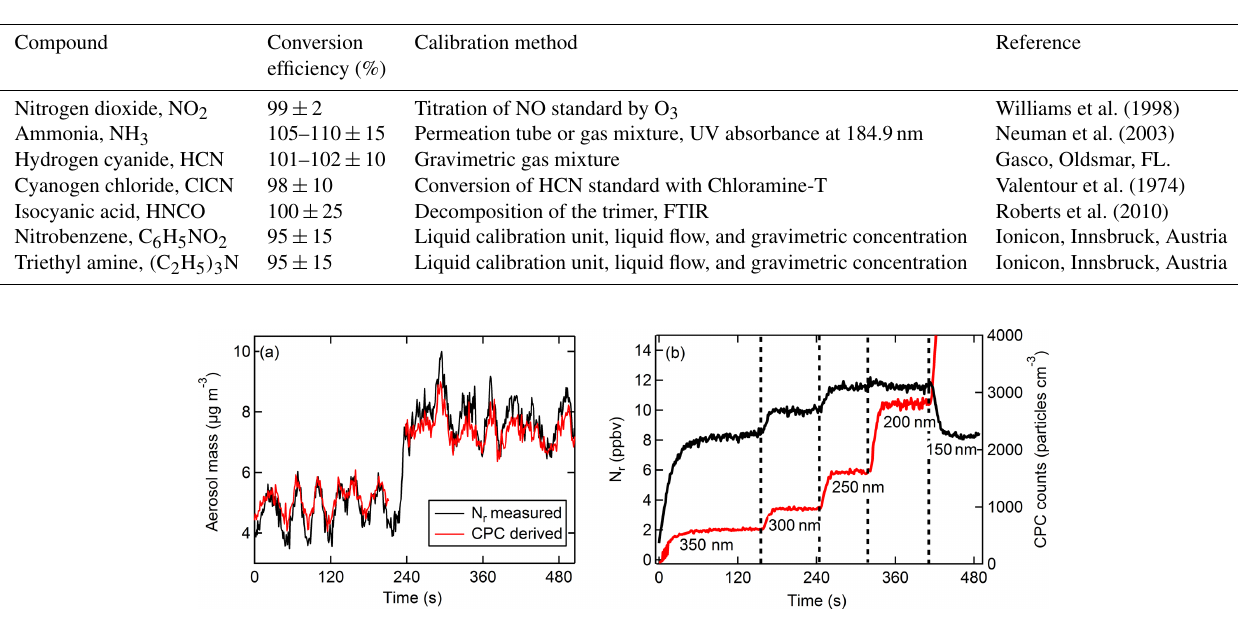
Table 1. Conversion efficiencies of N r compounds by the Pt and MoOx catalyst system.